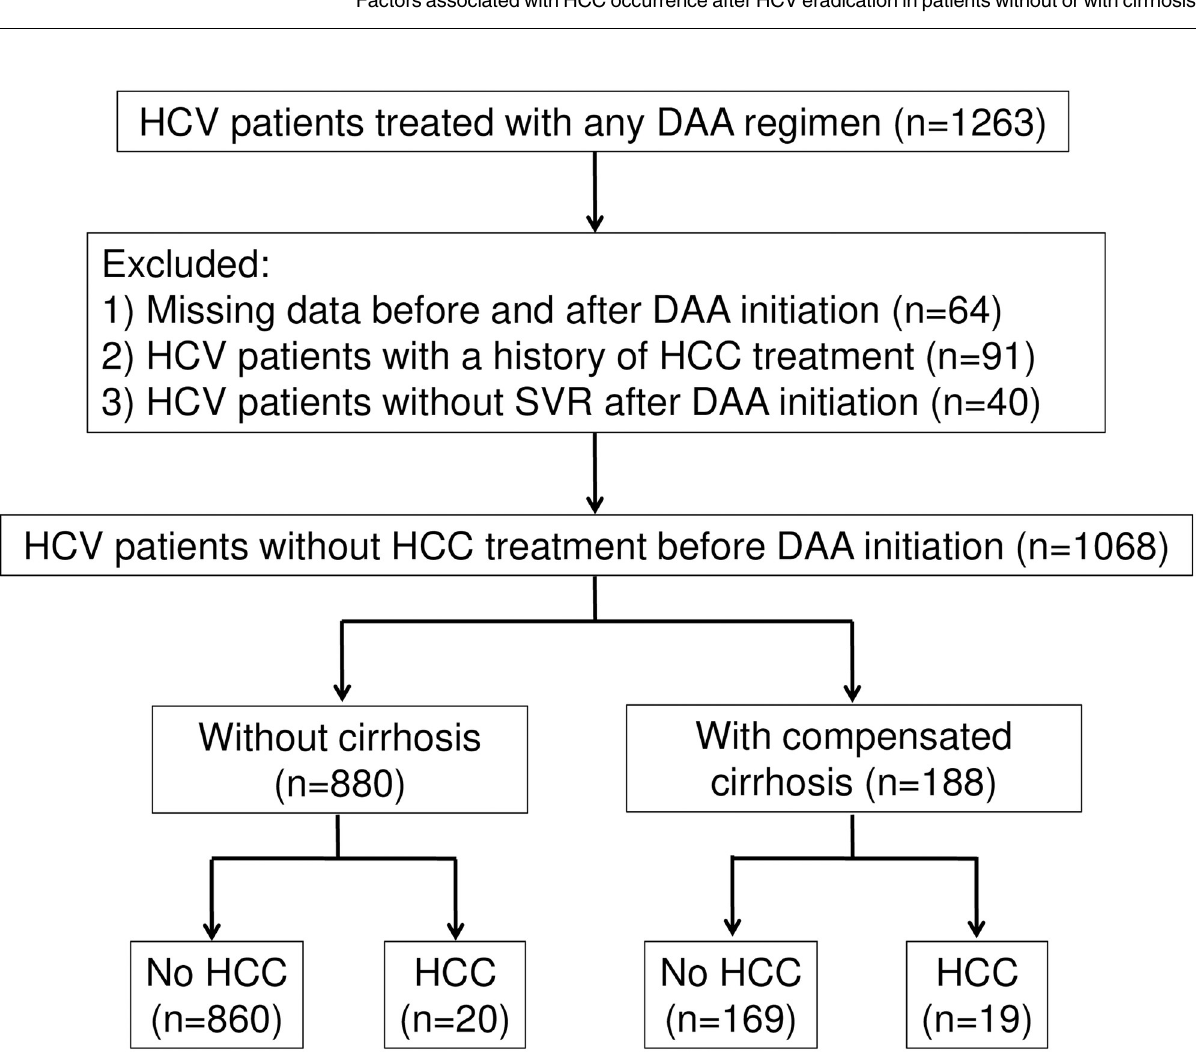
Fig 1. Diagram of the patient selection